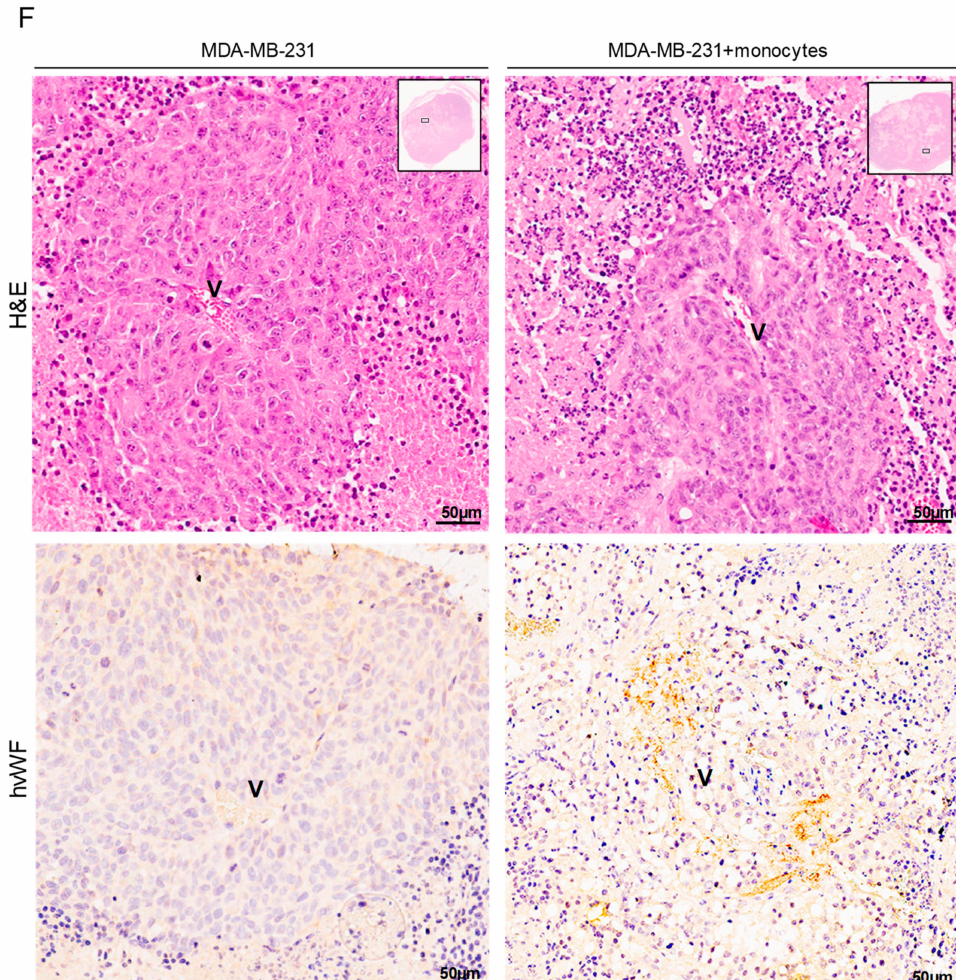
Figure 5. Tumors grown in the presence of monocytes have increased tumor volume and some vessels with human vWF (hvWF) staining. ( A ) 3D spheroids of HCC1954 in co-culture with monocytes stained for hvWF (green) and fibronectin (FN) (red) (bars 10 µ m). DAPI (blue) stains nuclei, magnification 400 × . ( B ) Representative imagens of tumors from mice with breast cancer cells (MDA-MB-231), without and with monocytes previously cultured under VEGF. ( C ) Tumor volume (mm 3 ) 24 and 45 after inoculated mice with breast cancer cells (MDA-MB-231), without and with monocytes previously cultured under VEGF. ( D ) Quantification of tumor necrotic areas, 45 days after the inoculation of MDA-MB-231 with and without monocytes cultured in VEGF. ( E ) Quantification of tumor viable areas, 45 days after the inoculation of MDA-MB-231 with and without monocytes cultured in VEGF. ( F ) Immunohistochemistry (IHC) for hvWF (black arrow) in MDA-MB-231 tumors in the presence and absence of monocytes cultured in VEGF (bars 50 µ m). Optical microscopy, nuclei are blue (hematoxylin). Blood vessels are signed with